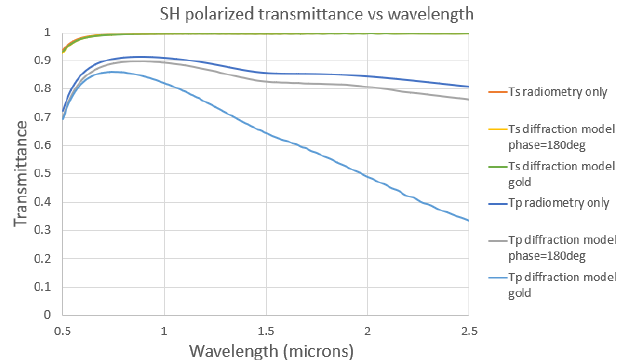
Figure 12. SH transmittance vs. polarization and wavelength for w = 36µm, L = 1mm, and F number = 4.5. We note the transmit- tance for S-polarized light is nearly identical for the three different models, while the P polarization response depends significantly on the treatment of the phase shift interaction with the surface. The transmittance drops precipitously when we allow the phase shift to vary at reflection in response to a realistic gold surface.